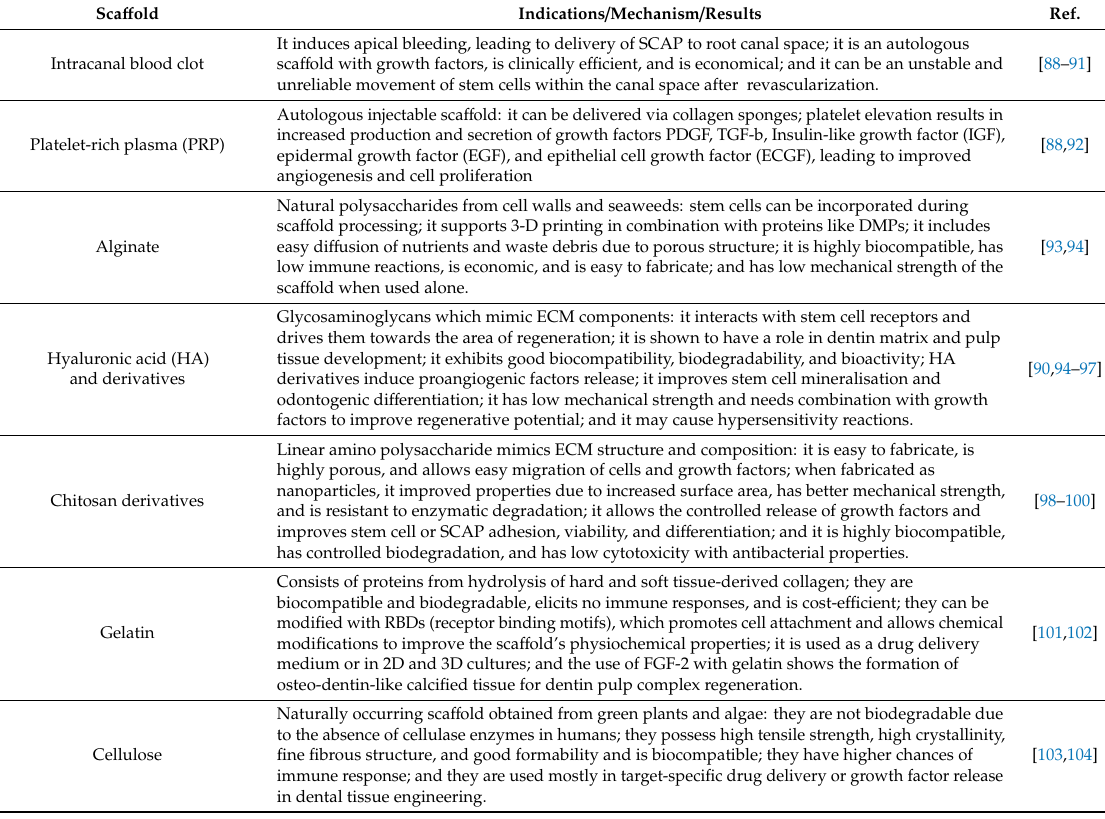
Table 5. Sca ff old-based regeneration of the dentin-pulp complex (cell homing strategies). Sca ff old Indications / Mechanism /